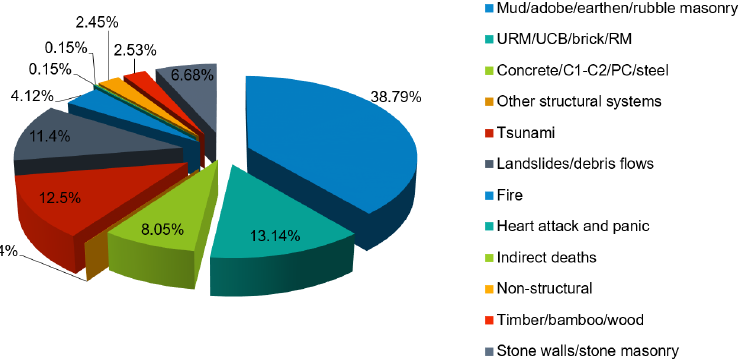
Figure 2. Seismic occurrences and deaths as a result of secondary effects for deadly earthquakes across the world